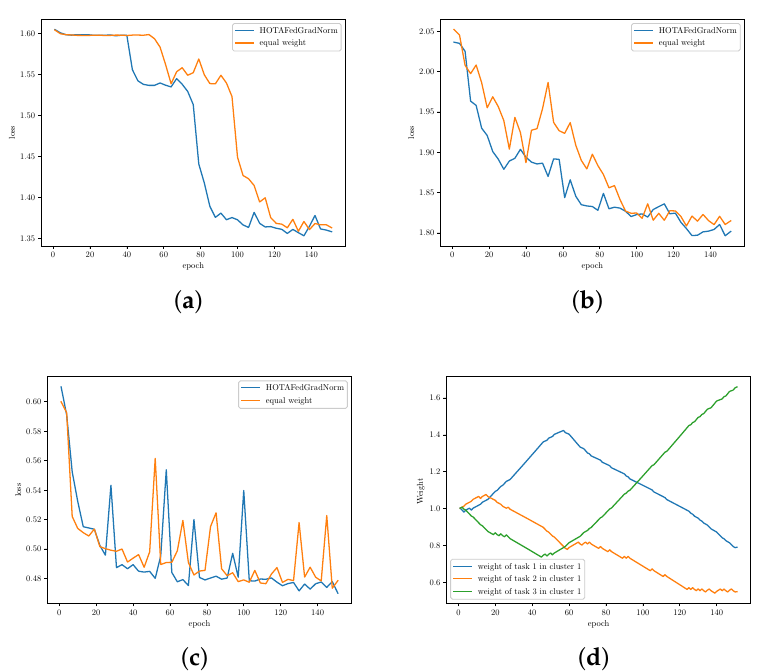
Figure 5. Comparison between task loss achieved via HOTA-FedGradNorm and naive equal weighting case in RadComDynamic dataset for the first cluster ( a ) task 1 (modulation classification), ( b ) task 2 (signal classification), ( c ) task 3 (anomaly behavior), (d) task weights.